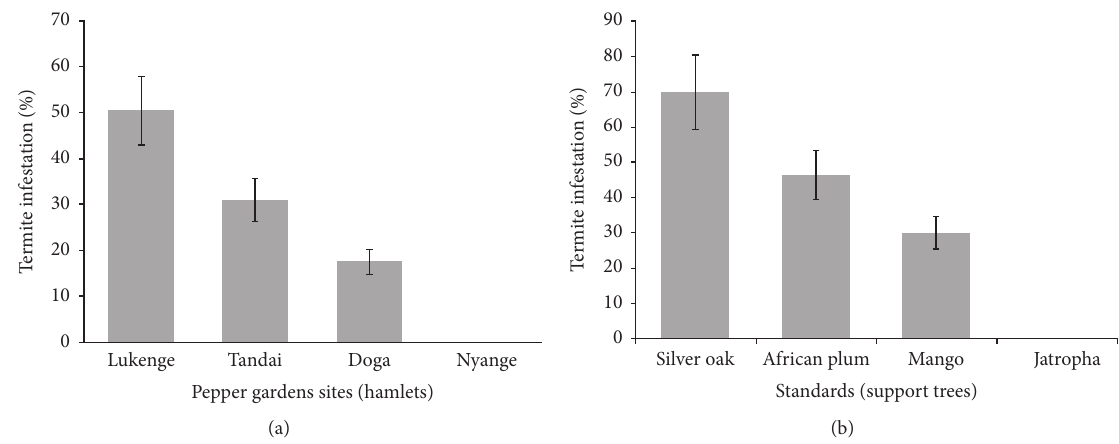
Figure 5: Results of a survey of Tandai village in Morogoro district, Tanzania, where pepper farms were surveyed for symptoms of spike shedding and stem wilting. (a) Termite pest infestation in pepper plants in gardens. (b) Termite infestation in pepper gardens as influenced by the type of standards.